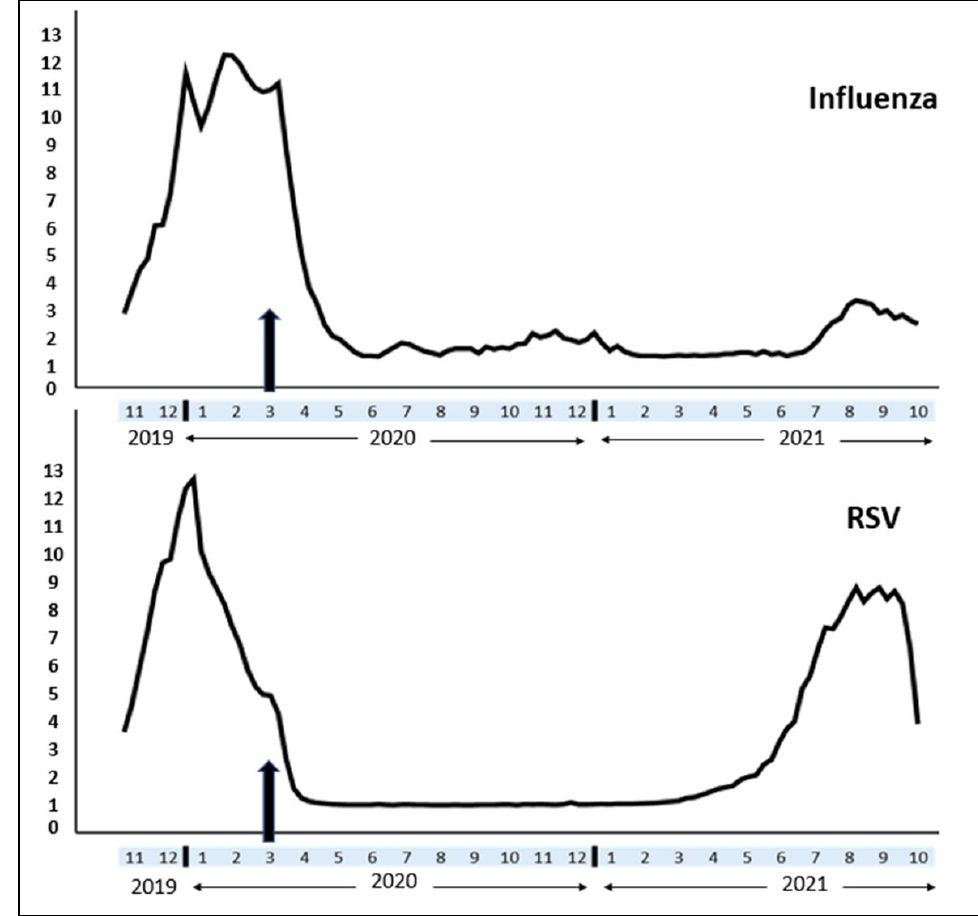
Figure 2. Seasonal variation in flu and RSV activity (1 – 13 scale) over the last two years (from November 2019 to October 2021). The vertical arrow indicates the time when COVID-19 was declared a pandemic.